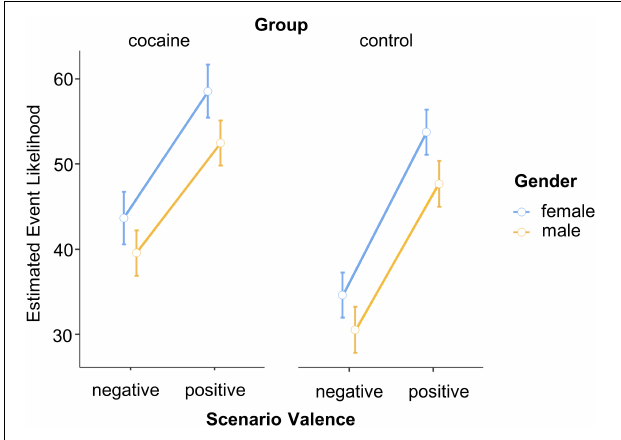
FIGURE 7 | Self-related future expectancies. Error bars, standard